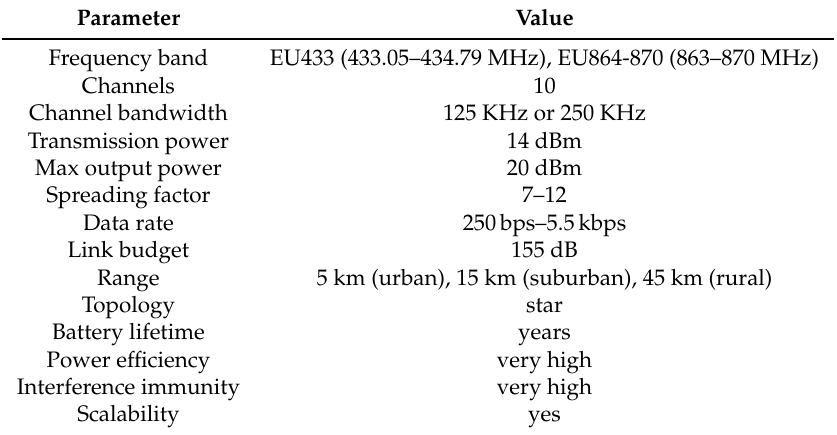
Table 3. LoRa/LoRaWAN main specifications